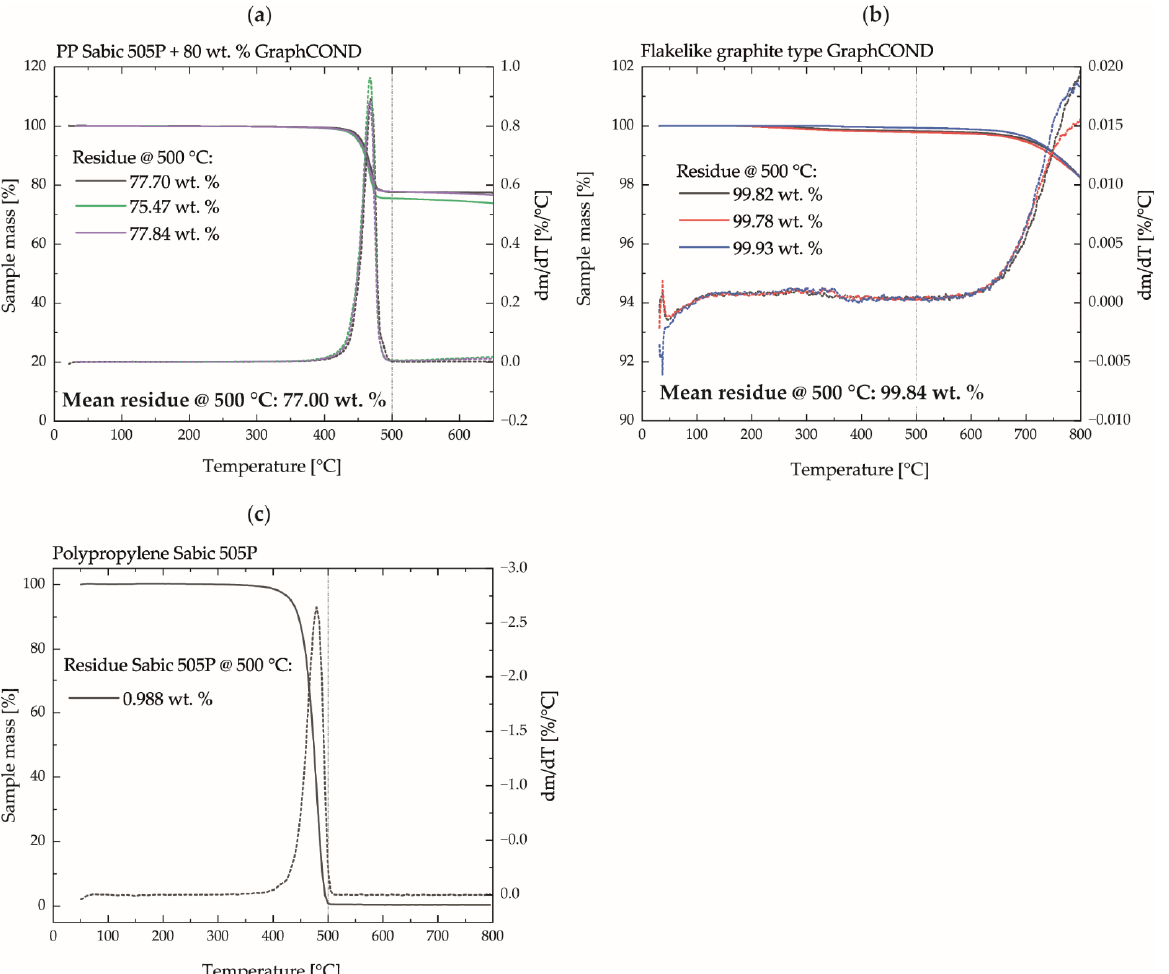
Figure 5. ( a ) Thermogravimetric analysis of the compound with maximum graphite content; ( b ) thermogravimetric analysis of the pure Graphite particles; ( c ) thermogravimetric analysis of the pure PP. The results of the measurement of pure graphite show that there is hardly any decrease in mass at the measured temperatures. At 500 ◦ C, a residual mass m g , res ( 500 ◦ C ) of about 99.8 wt.% graphite was evaluated, Figure 5b. The measurement error due to carbonaceous residues from the degraded PP was determined by measuring the pure PP and determining the residual PP mass content at 500 ◦ C m pp , res ( 500 ◦ C ) to approx. 0.98 wt.%, Figure 5c. Thus, the resulting filler content in the compound f c used for the ICM-DT experiments is calculated according to Equation (3) to 75.8 wt.% and is in good agreement with the set filler content from the the slow cooling rate of 2 K·min − 1 . For this reason, the equations for calculating the pres- sure-dependent shift of the crystallization range were derived from the determined slope of the pressure-dependent crystallization temperature of the pvT measurements and the determined y-intercepts as the absolute position of the solidification range of the DSC measurements, Figure 6c.